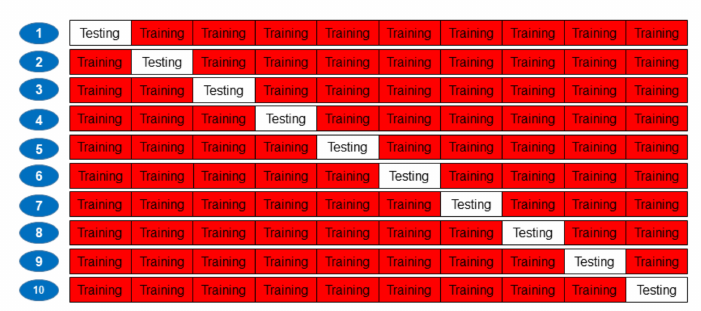
Figure 2. 10-fold